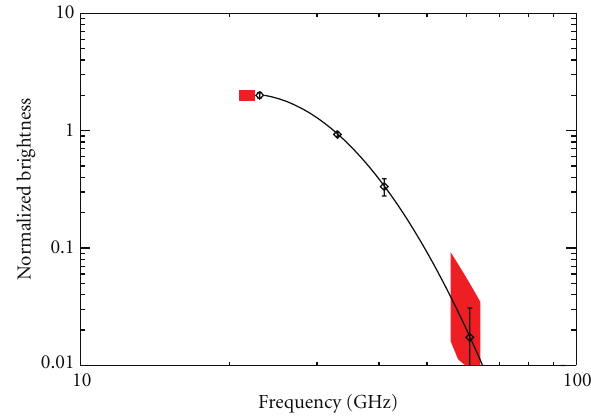
Figure 4: Best-fit AME model (black line) and results in terms of ν p and m 60 considering 1 σ uncertainties (red areas). The peak frequency results ν p = 21 . 7 ± 0 . 8. Diamonds with error bars are the results in terms of normalized intensity at WMAP bands and related uncertainties.